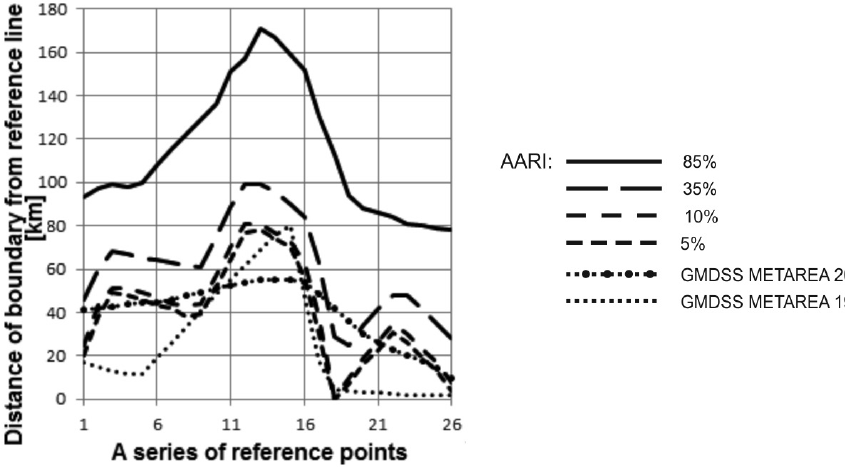
Fig. 8. Distances of boundaries from the reference line (developed by the